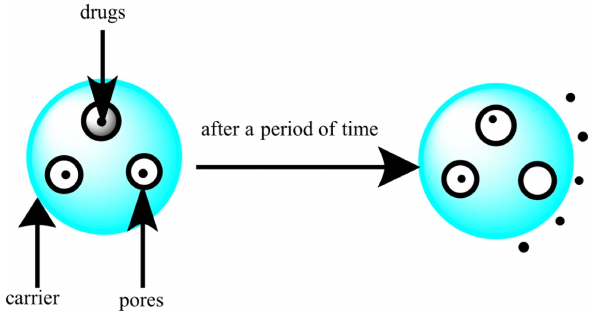
Figure 2: Principle of ceramic-based DDS